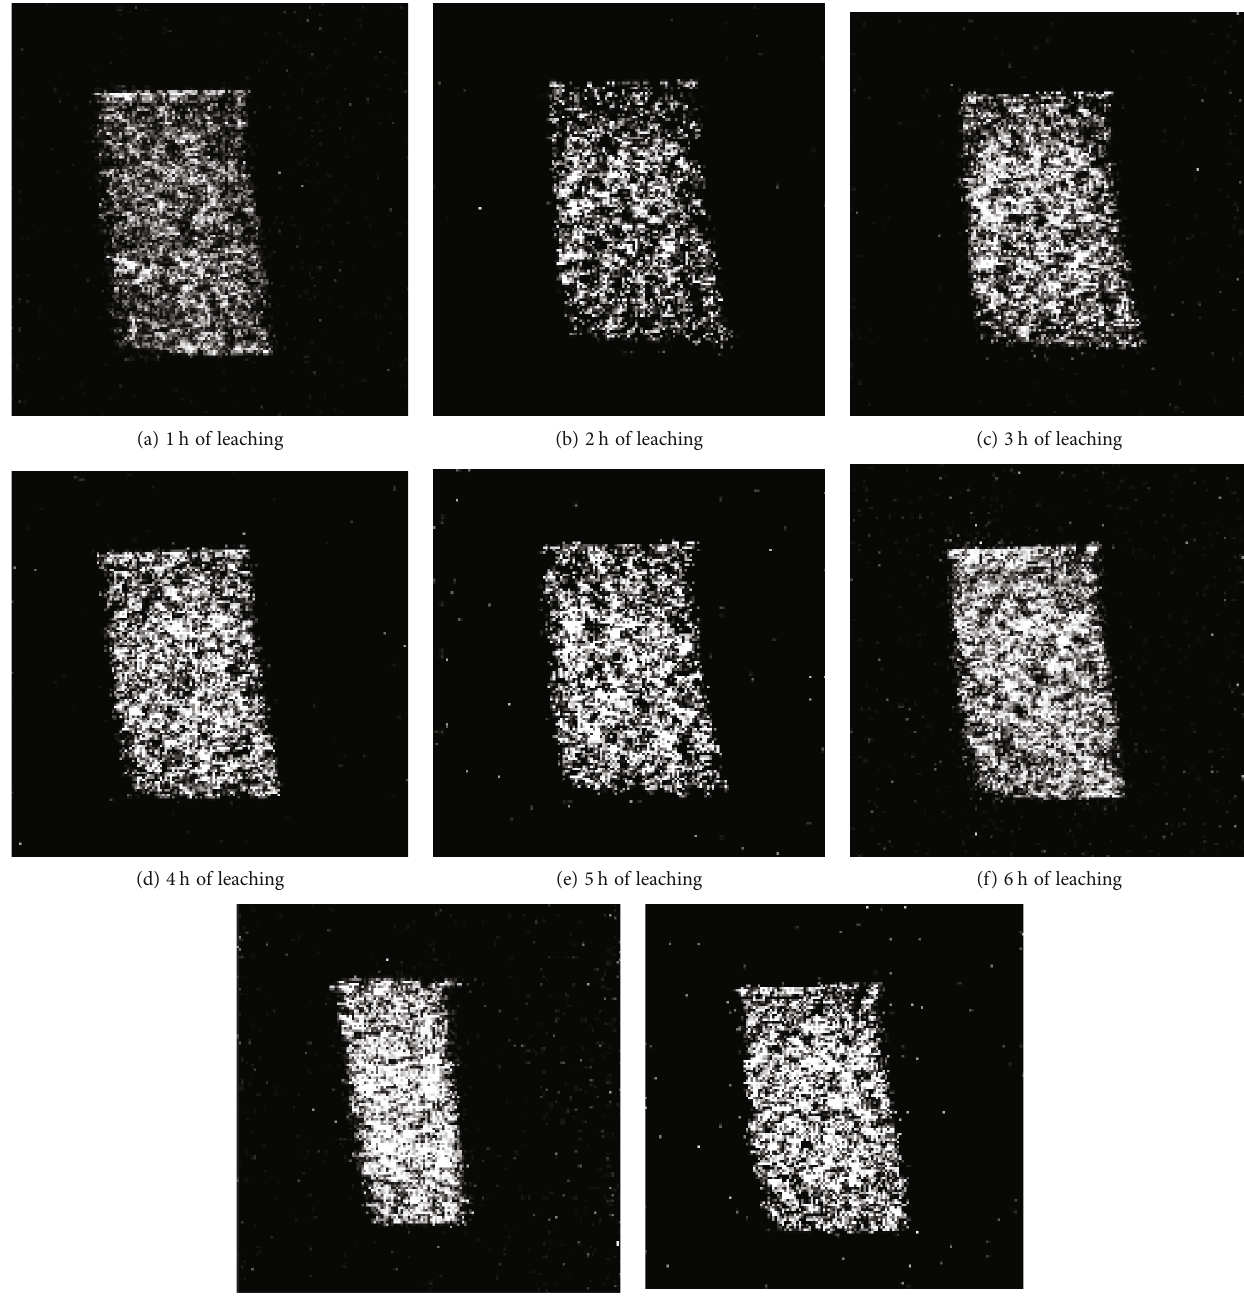
Figure 10: Vertical axis pro fi le of deionized water leaching